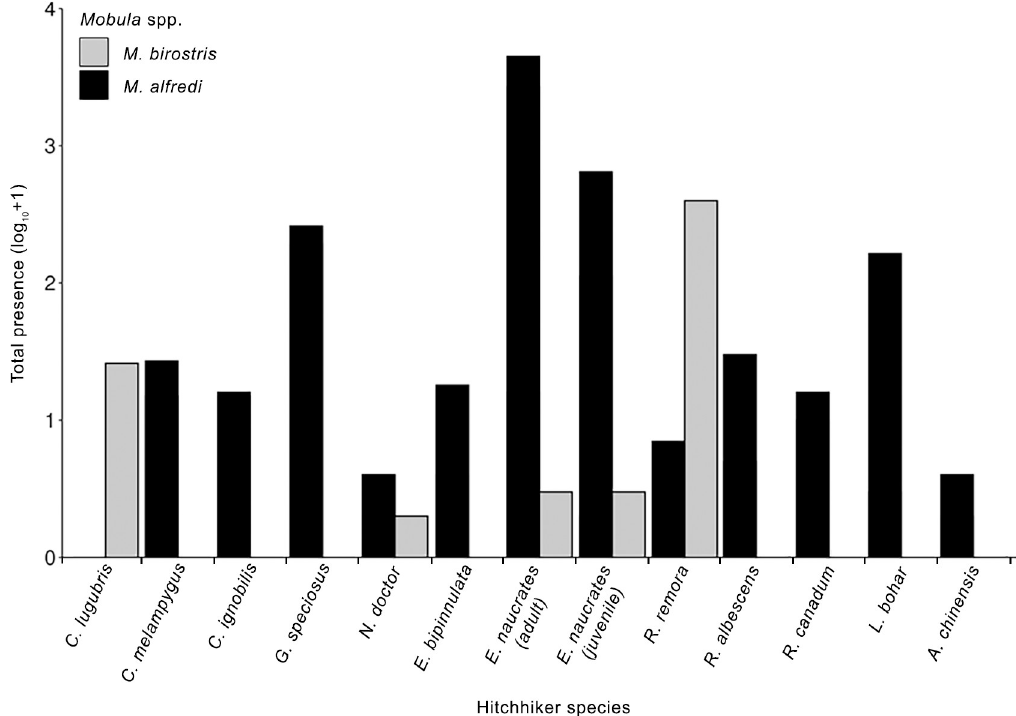
Fig 3. Total presence of hitchhiker species observed with manta rays. The total number of sightings where each identified hitchhiker species ( n = 12) was observed with Mobula alfredi (black) or M . birostris (grey). A (10+1) transformation was used for better visualisation of the